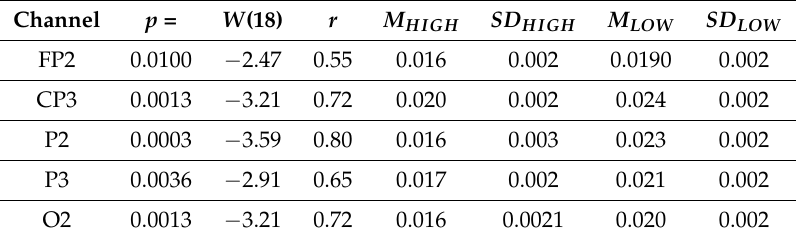
Table 2. Eyes-Closed (EC) setting. Channel-wise paired Wilcoxon rank sum test for five channels (FP2, CP3, P2, P3, and O2) in which higher total TEs were associated with LOW stress-susceptible group. p , W , and r refer to p -value, test-statistics, and the effect size for Wilcoxon rank sum tests. M and SD are the mean and standard deviation of these channels’ total TE values. The subscripts to M and SD mark the two groups. All these significant differences were characterized by strong effect sizes, as indicated by the “ r ” column entry of this table.